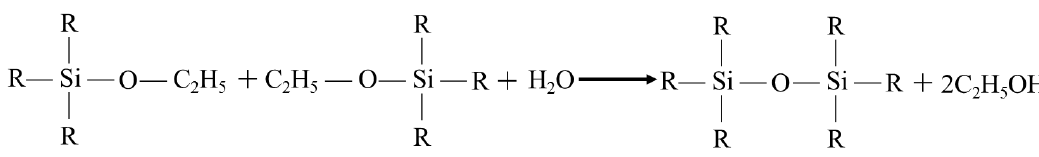
Figure 1. Reaction equation for preparing prepolymer of silicone resin.